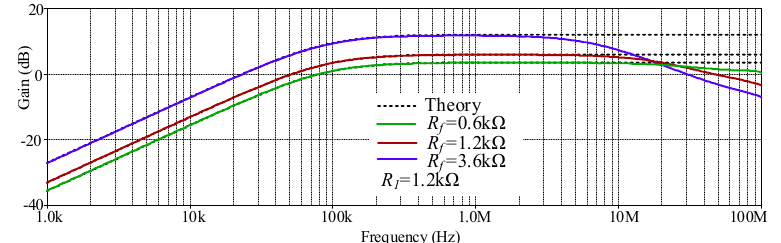
Figure 8. Simulated gain response of HP with different R f values.